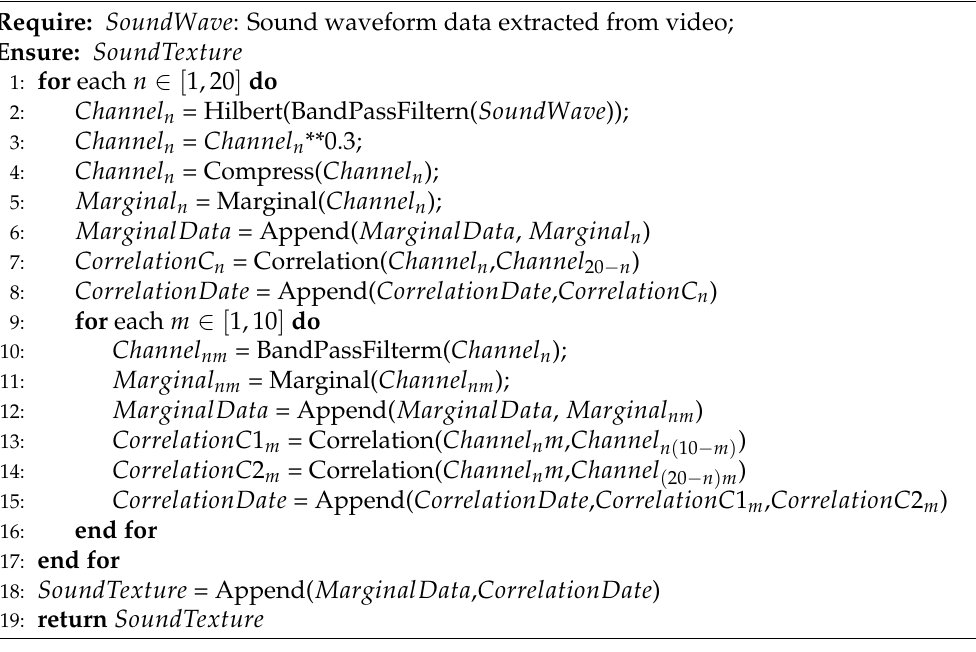
Algorithm 1 Micro Attention branch